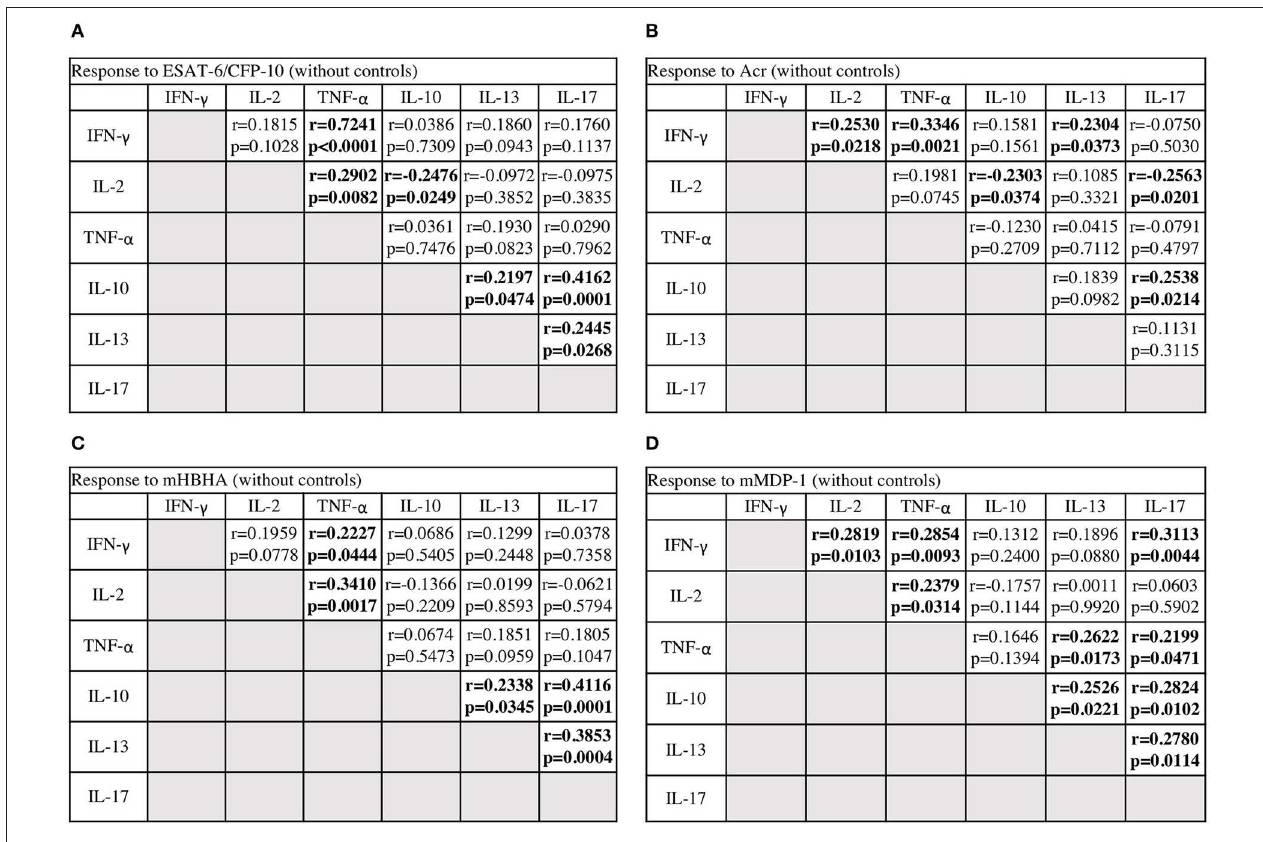
FIGURE 5 | The correlations between cytokines in response to M. tuberculosis antigens among M. tuberculosis -infected cases. The correlations between each cytokine were assessed using Spearman correlation test. (A) Against ESAT-6/CFP-10. (B) Against Acr. (C) Against methylated (m) HBHA. (D) Against